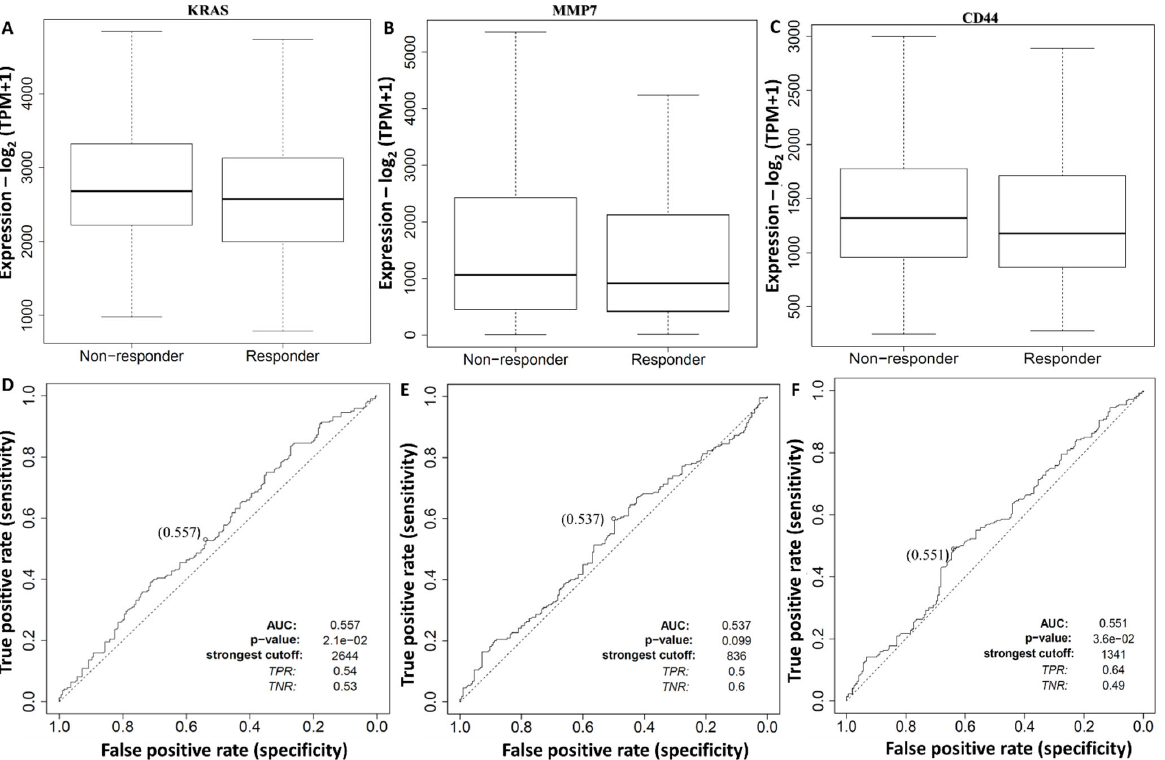
Figure 5. Diagnostic receiver operating characteristic (ROC) curves of the KRAS/MMP7/CD44 onco- genes distinguishing colorectal adenocarcinoma (COAD) responding and non-responding patients. ( A – C ) Boxplot center lines showing expressions of the KRAS/MMP7/CD44 genes in a COAD cohort